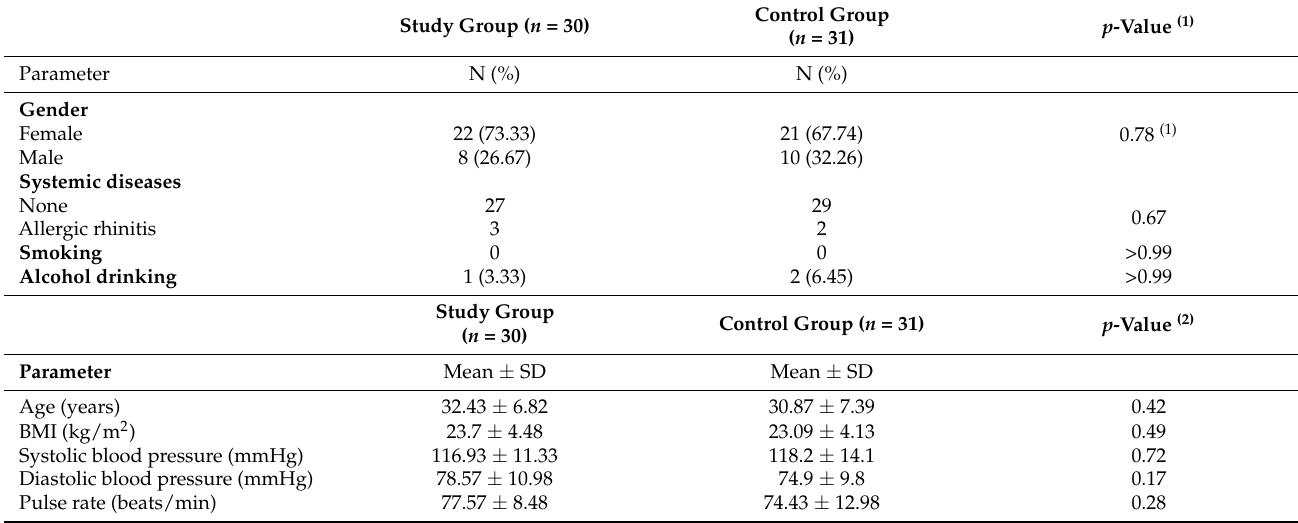
Table 1. Demographic characteristics of the participants at baseline.